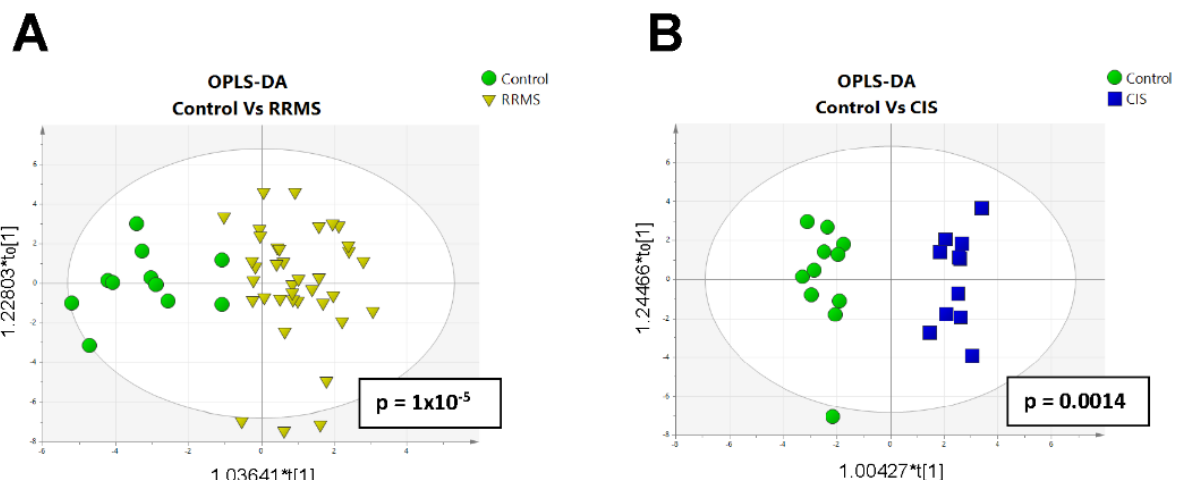
Figure 1. Orthogonal Projection to Latent Structures Discriminant Analysis (OPLS-DA) of ( A ) RRMS vs. controls; ( B ) CIS vs. controls. CIS: Clinically Isolated Syndrome; RRMS: Relapsing-Remitting Multiple Sclerosis.